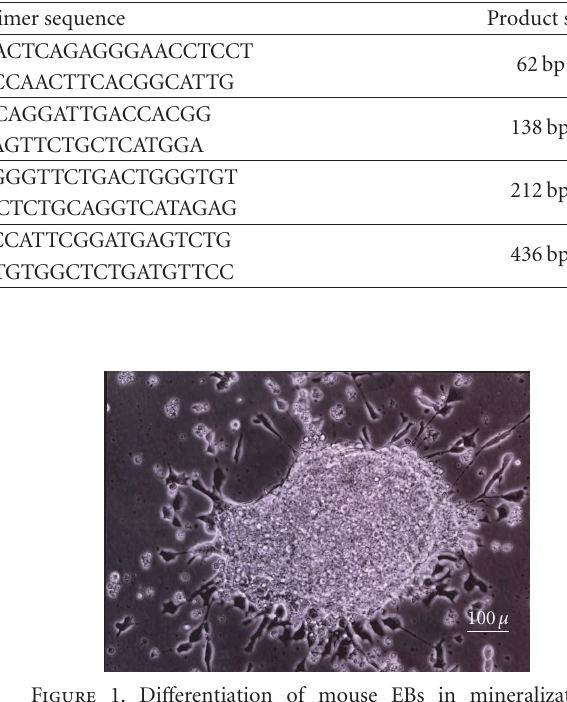
Figure 1. Di ff erentiation of mouse EBs in mineralization